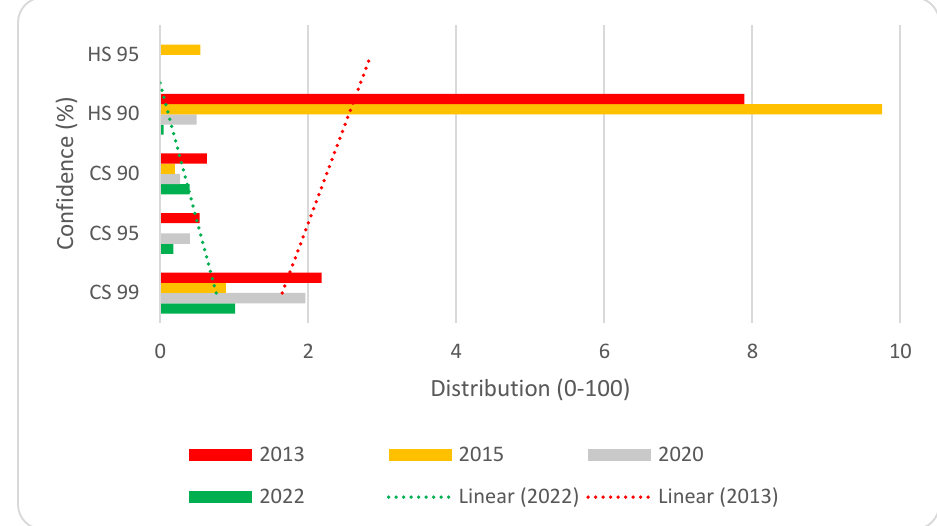
Figure 13. Normalized (0–100) distribution pattern of hot spot (HS) and cold spot (CS) values in the study area according to the studied years along with the trend line of changes in 2013 and 2022. Because the non-significant spots were in the majority in each year, they were 100 and were masked for chart better